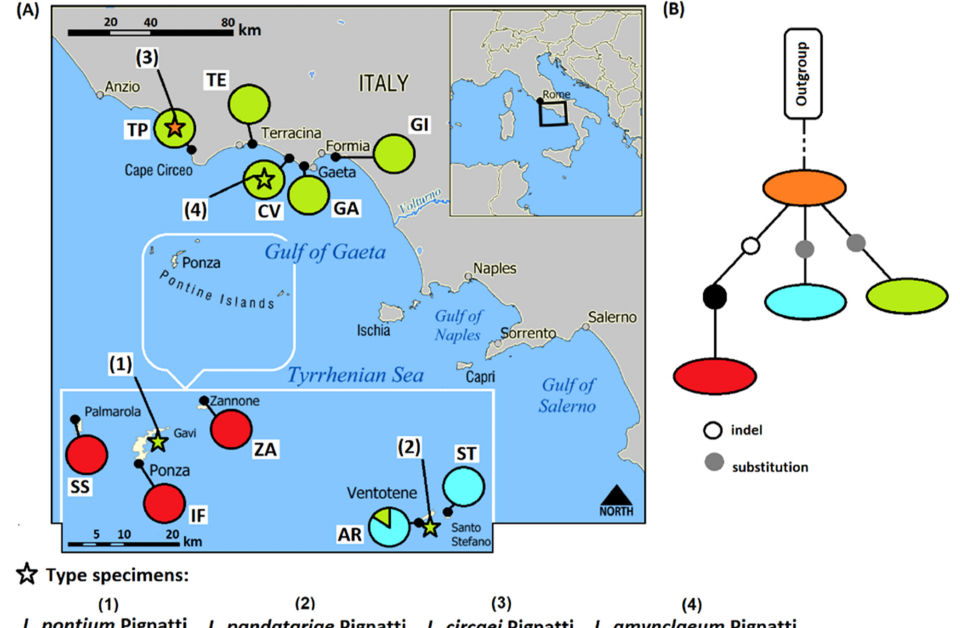
Figure 4. ( A ) The ten localities of the investigated Limonium populations (80 individuals) and corresponding haplotypes obtained with trn L (UAA) intron + trn L (UAA) - trn F (GAA) IGS and pet B- pet D IGS + pet D intron (cpDNA). Type specimens for the four Limonium species analyzed were reported as star symbols with numeric legend. ( B ) Information is also shown for the plastid DNA haplotypes and the corresponding statistical parsimony network using TCS software where the black dots represent undetected haplotypes (outgroup = L. pruinosum ). Codes correspond to the population localities shown in Table 1; colored symbols correspond to the haplotypes shown in Table